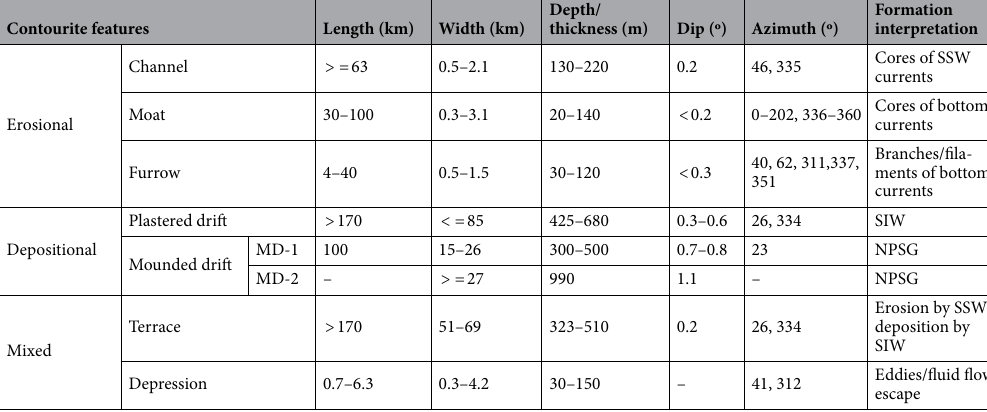
Table 1. Morphological parameters and interpretation of contourite features in this